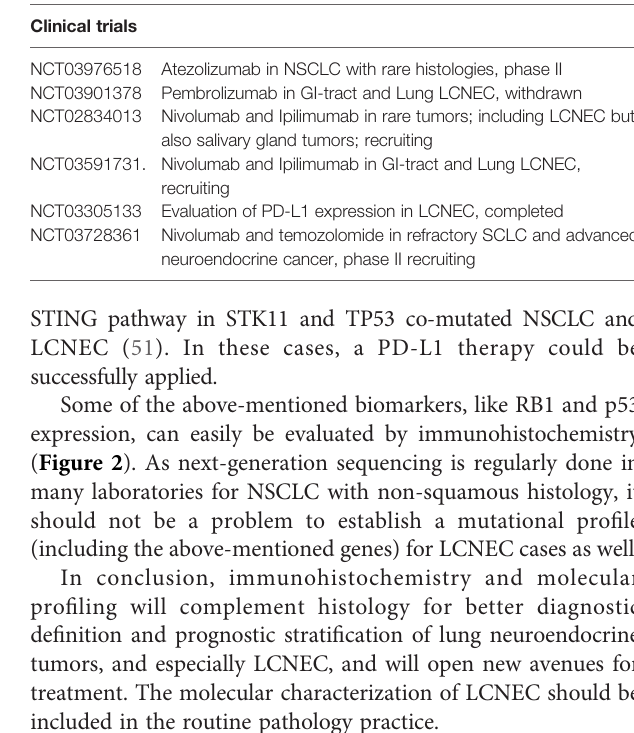
TABLE 1 | Studies reporting on treatment modalities for LCNEC; TILs, tumor associated lymphocytes; TMB, tumor mutational